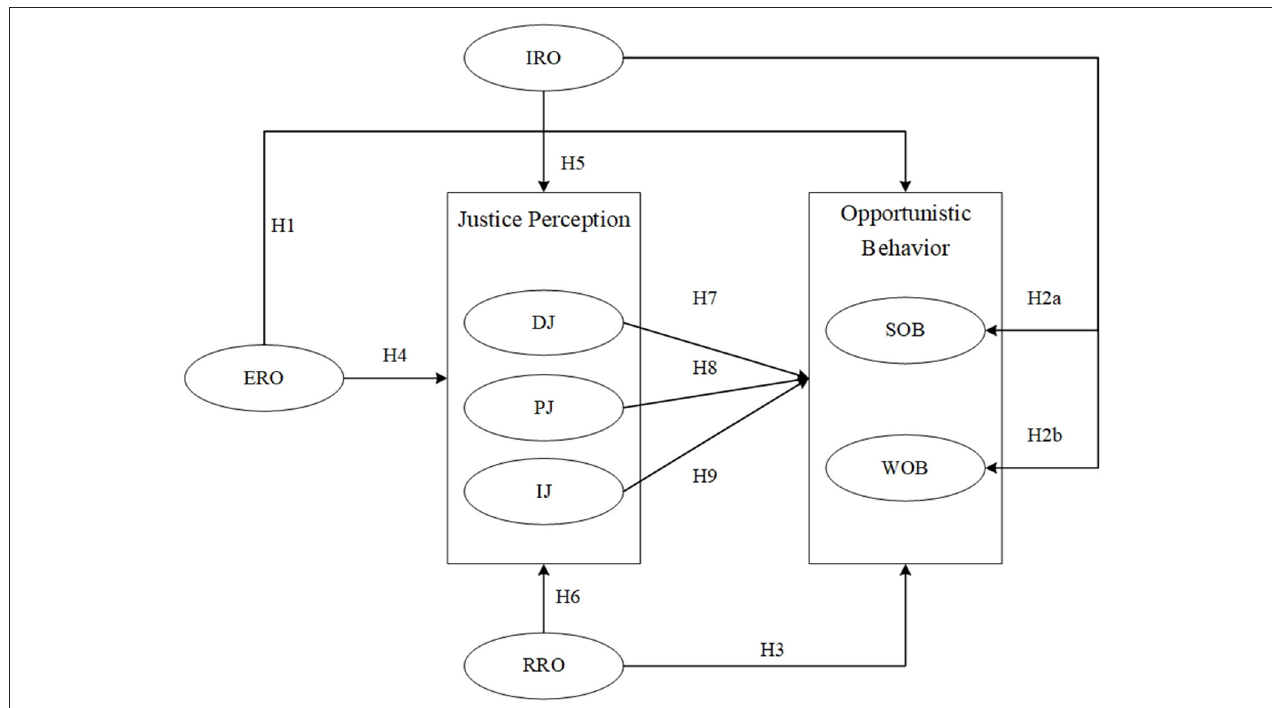
FIGURE 1 | Conceptual model of the effect of public sector’s relationship